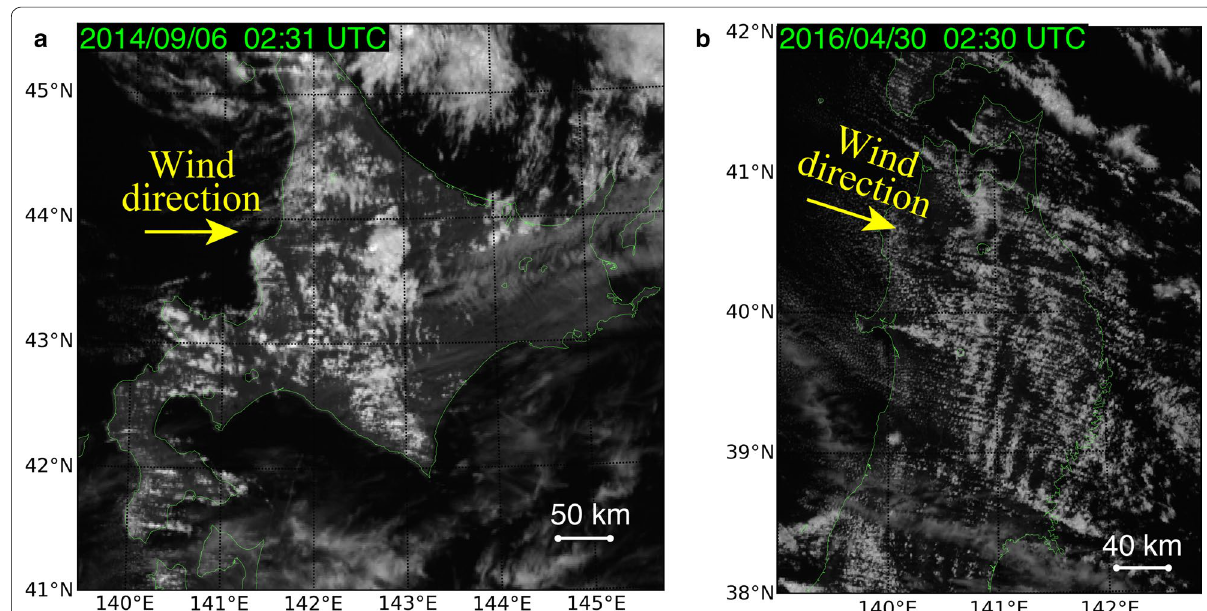
Fig. 5 Visible satellite images derived from a MTSAT-2 on 02:31 UTC of September 6, 2014, and b Himawari-8 on 02:30 UTC of April 30,